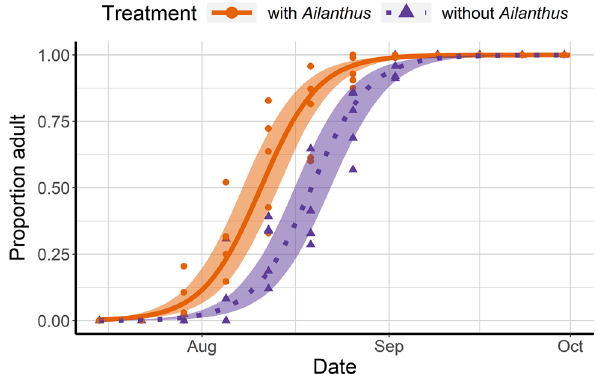
Figure 4. Proportion of L. delicatula that emerged as adults over time, with fitted logistic regression lines, for enclosures with and without Ailanthus altissima .